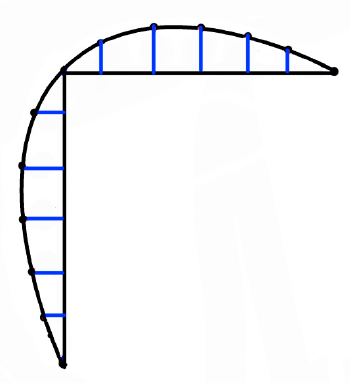
Figure 6. Schematic diagram of the evaluation function.